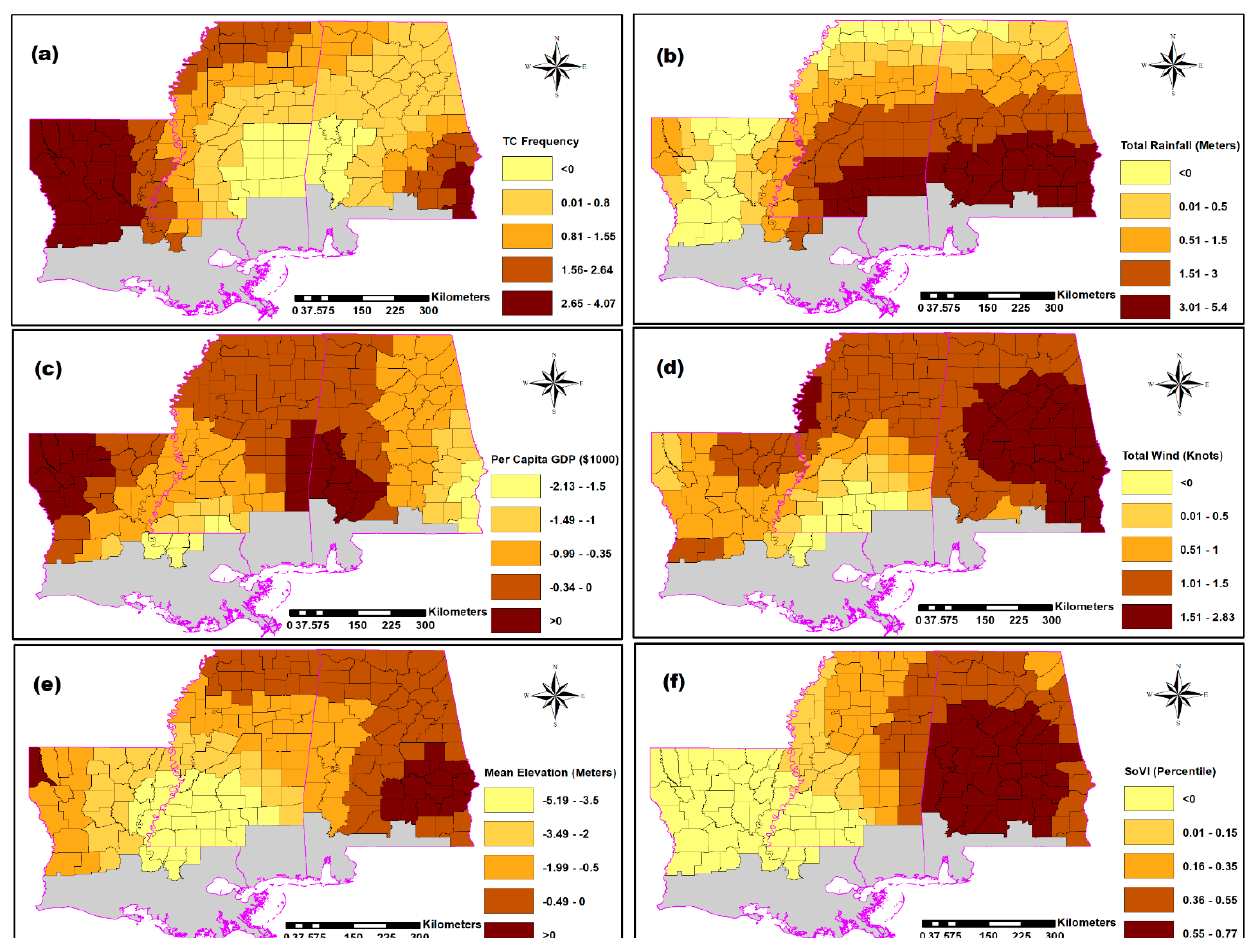
Figure 4. Spatial distributions of coefficients of the six independent variables in the GWR model: ( a ) TC frequency; ( b ) TC rainfall; ( c ) per capita GDP; ( d ) TC wind; ( e ) mean elevation; and ( f ) county SoVI percentile.